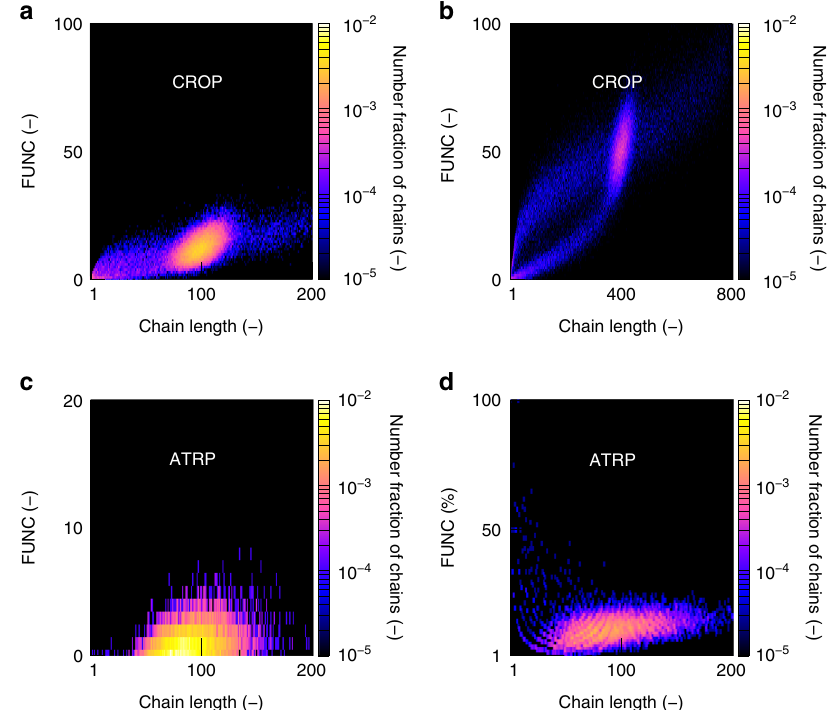
Fig. 10 Generic nature of concept of functionality-chain length distributioons. a , b case of synthesis of functional copoly(2-oxazoline) at 100% monomer conversion for target DP of a 100 and b 400 (optimized conditions from Fig. 9). c , d case of atom transfer radical polymerization (ATRP) of c styrene and N-propyl maleimide; and d ethylhexyl acrylate and glycidyl methacrylate (monomer conversion of 90%); conditions for ( c ): target DP of 100; [styrene] 0